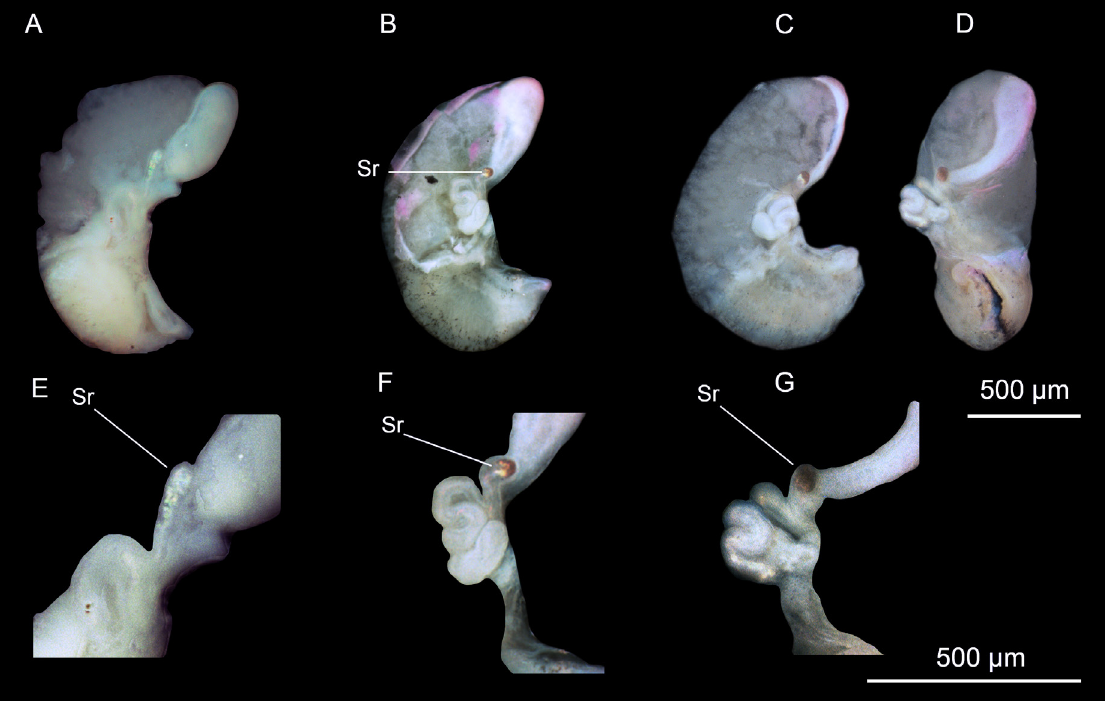
Fig. 14. Variation of the bursa copulatrix of Mercuria balearica (Paladilhe, 1869). A . Elongate, stream at Sant Joan de Carbonell, Minorca, Spain. B . Pyriform, Venta El Pilar Spring, Málaga, Spain. C–D . Pyriform, Fuente Valentín Spring, Alozaina, Cádiz, Spain. E–G . Detailed views of the seminal receptacle (Sr) and renal oviduct